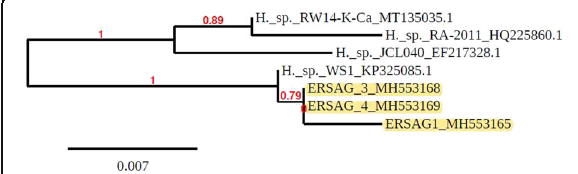
Fig. 1 Maximum likelihood ITS phylogenetic trees of Heterorhabditis species using ITS sequence. Based on nucleotide sequences of Heterorhabditis sp. (ERSAG1, ERSAG3, ERSAG4) and reference strains (alignment length ~ 700 bp using phylo_ tree